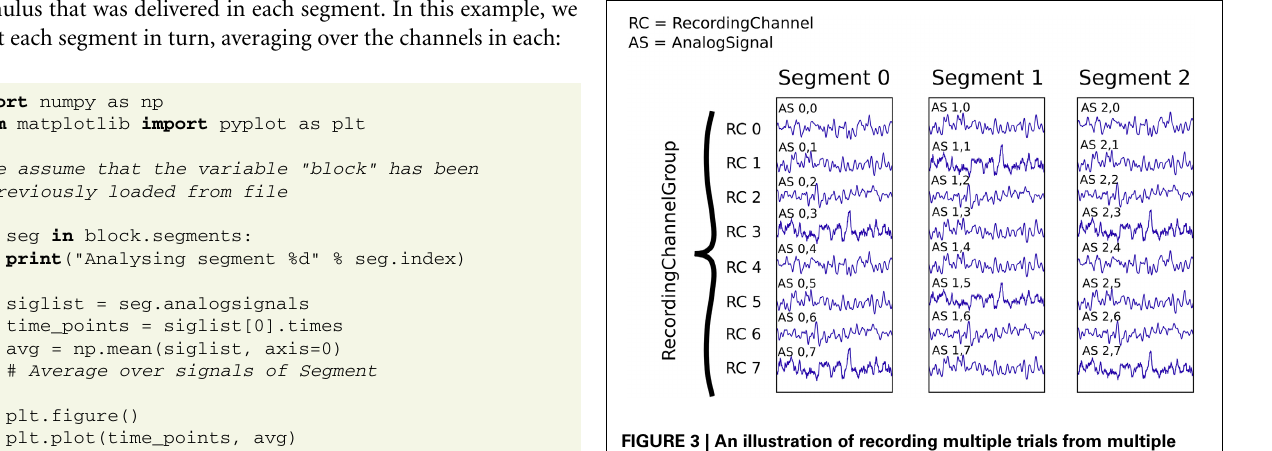
FIGURE 3 | An illustration of recording multiple trials from multiple channels. Each Segment contains the data recorded from a single trial. The RecordingChannel objects identify the channel on which a given signal was recorded, and hence link AnalogSignal objects across trials. The RecordingChannelGroup indicates that all channels are recorded from the same 8-channel probe. All the objects shown here are contained in a single Block, which is not explicitly